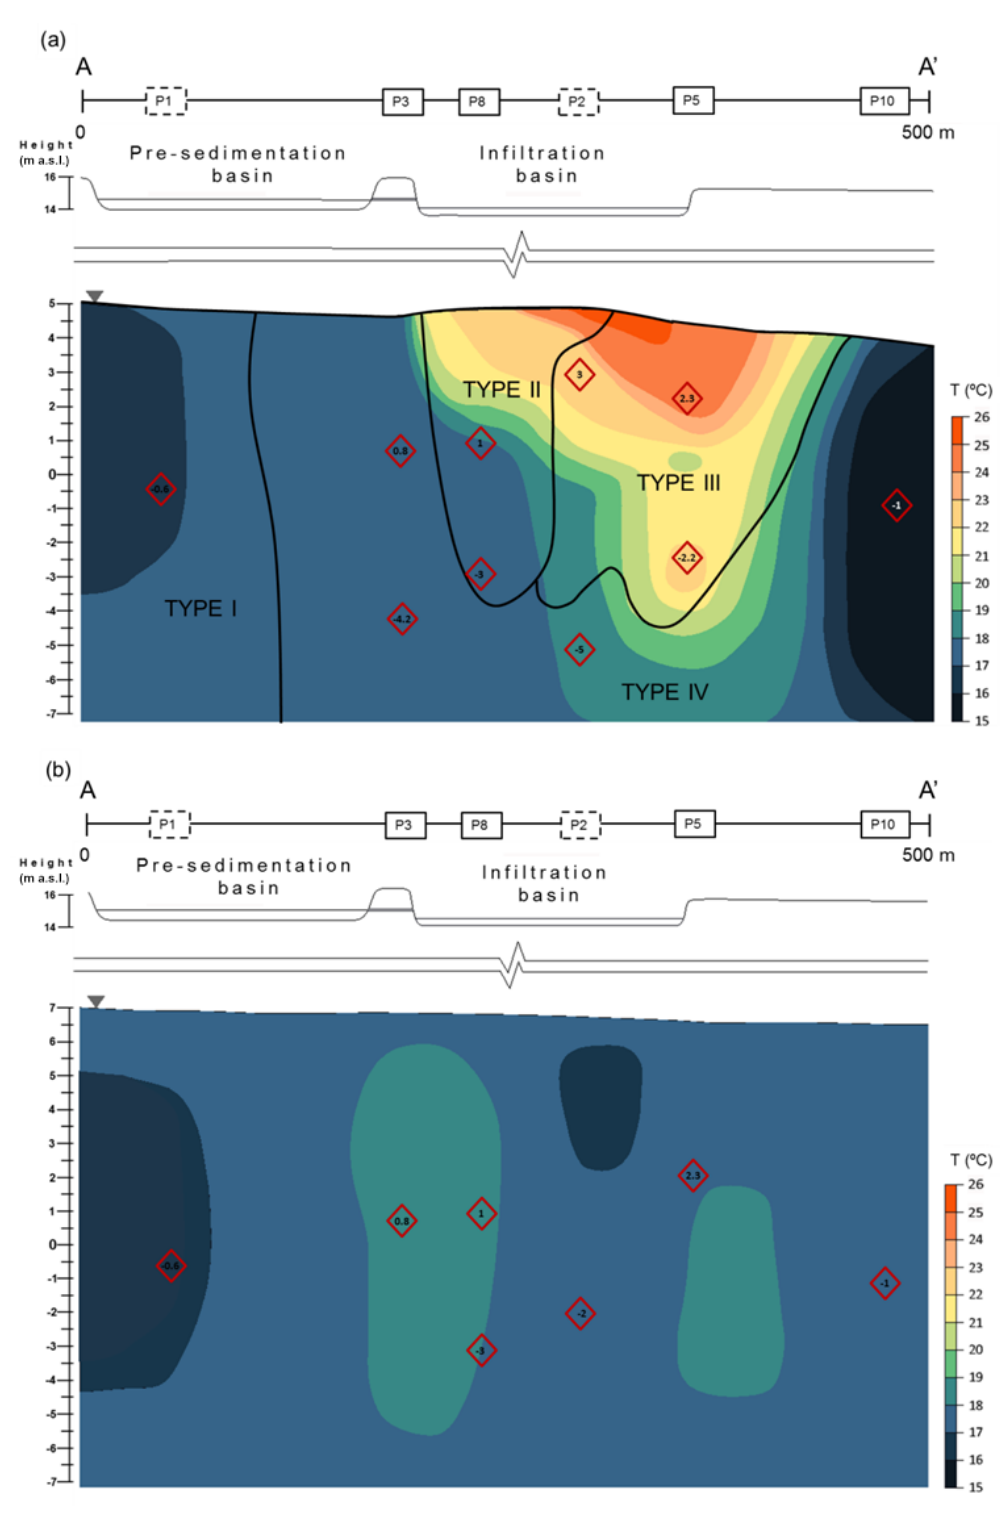
Figure 2. Temperature distribution at the local scale in (a) July 2014 (wet) and (b) March 2015 (dry). Red diamonds indicate sampling points for microbial and water analysis in each